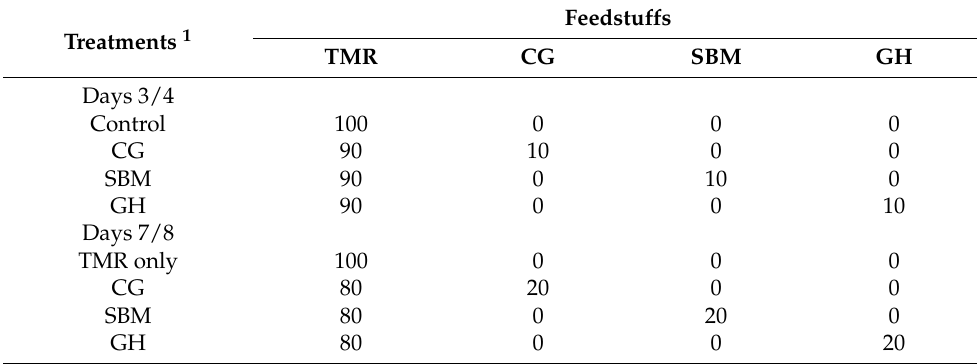
Table 3. Feedstuff inclusion rates in experimental treatment diets of TMR with and without the addition of CG, SBM, or GH (% of dietary net energy of lactation (NE L ) intake). Treatments